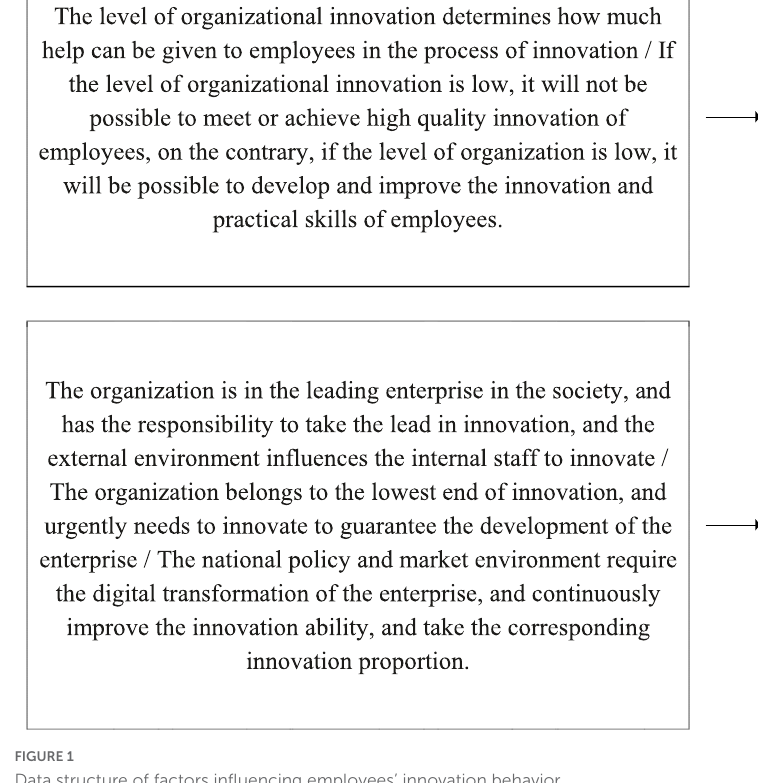
FIGURE1 Data structure of factors influencing employees’ innovation behavior.